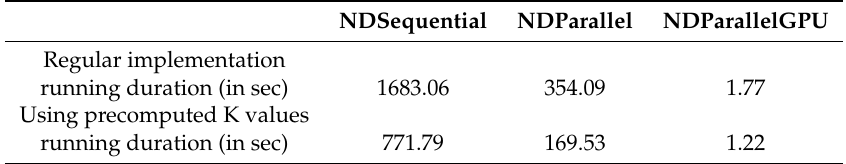
Table 3. Time comparison for the three diffusion algorithm types running on a 512 × 512 image.